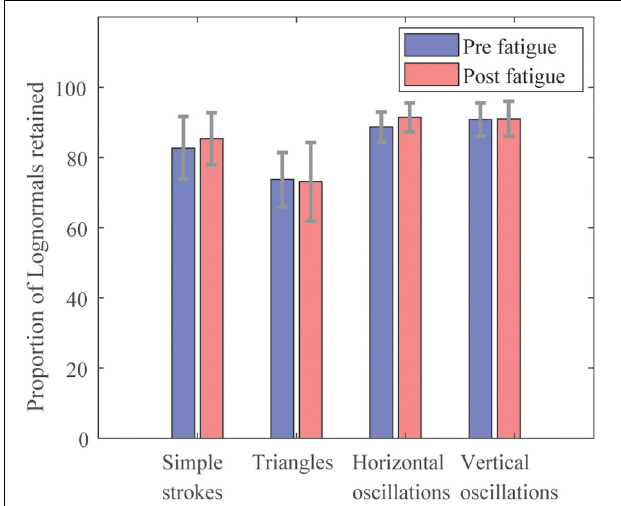
FIGURE 3 | Proportion of Lognormals retained by